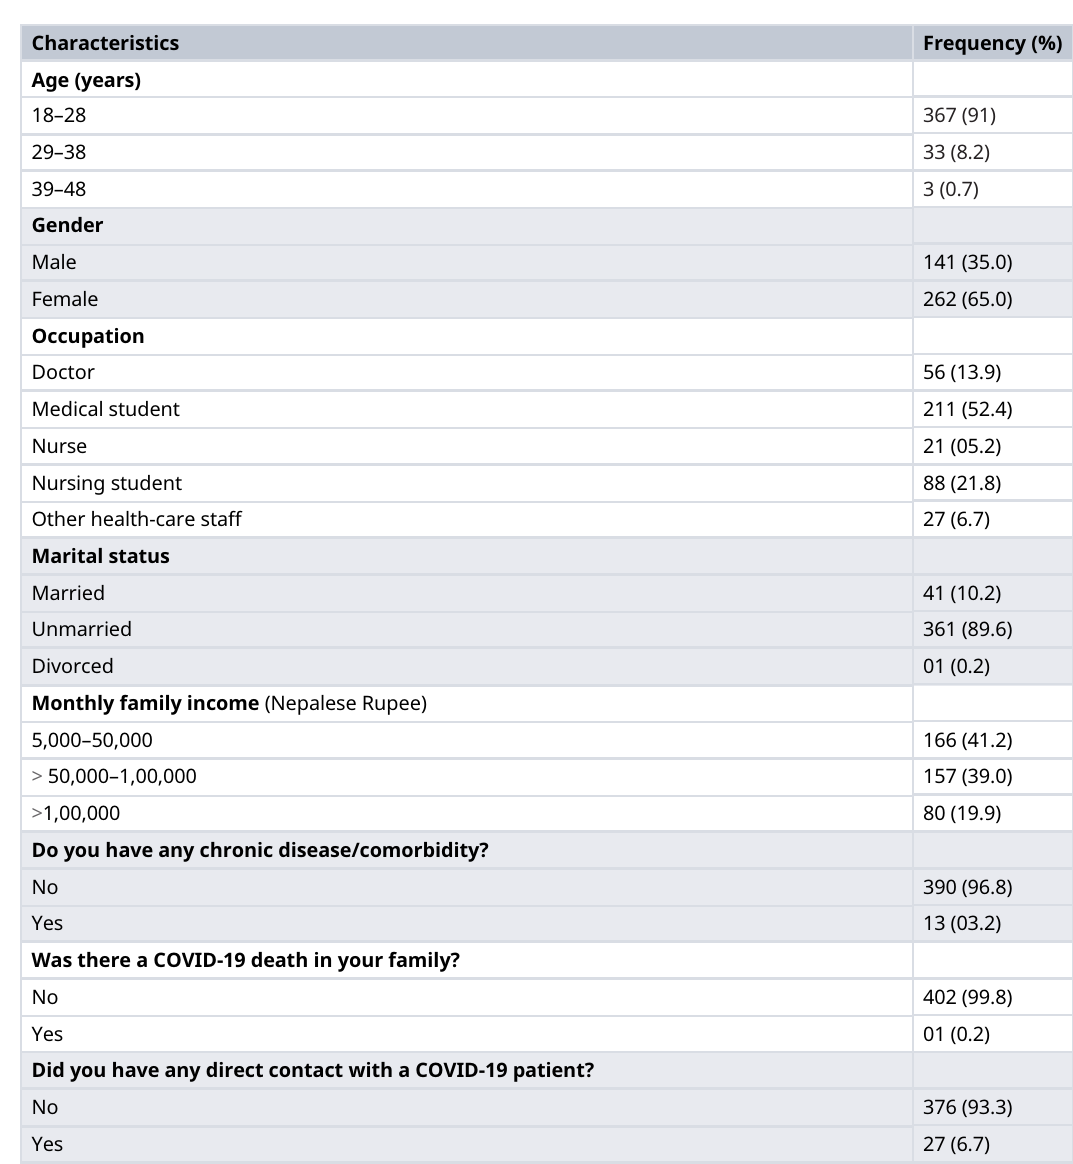
Table 1. Sociodemographic characteristics of the participants